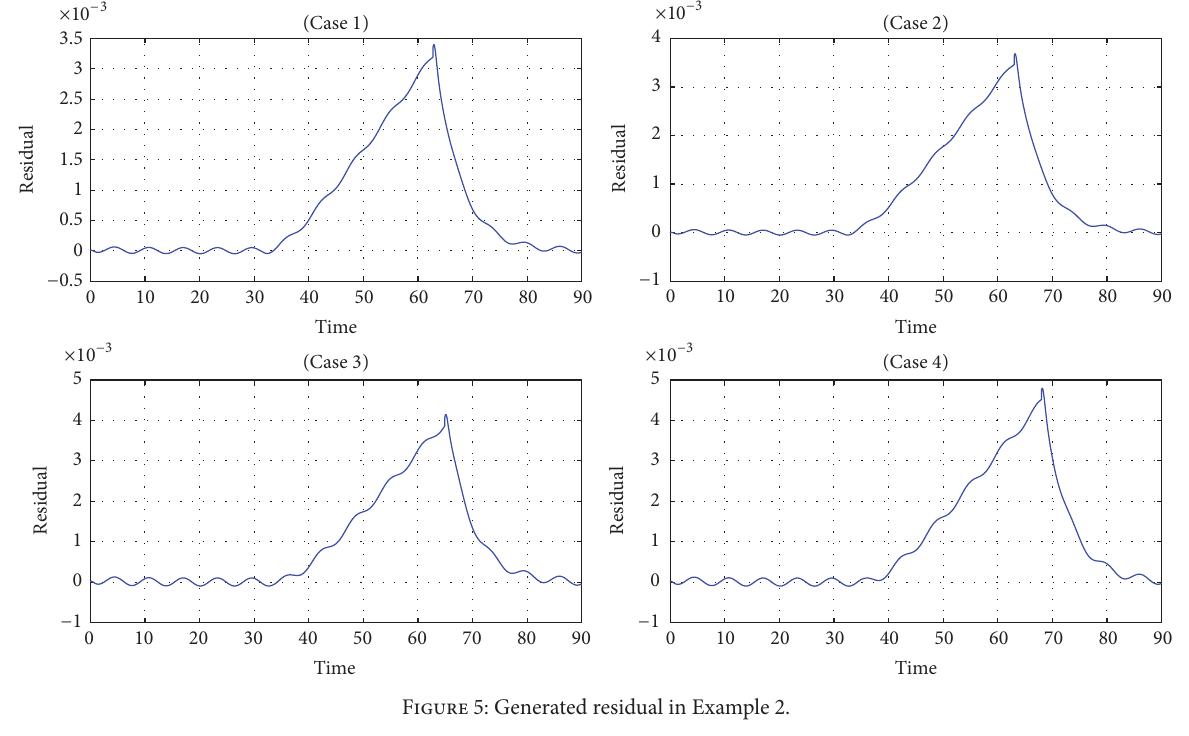
Figure 5: Generated residual in Example 2.